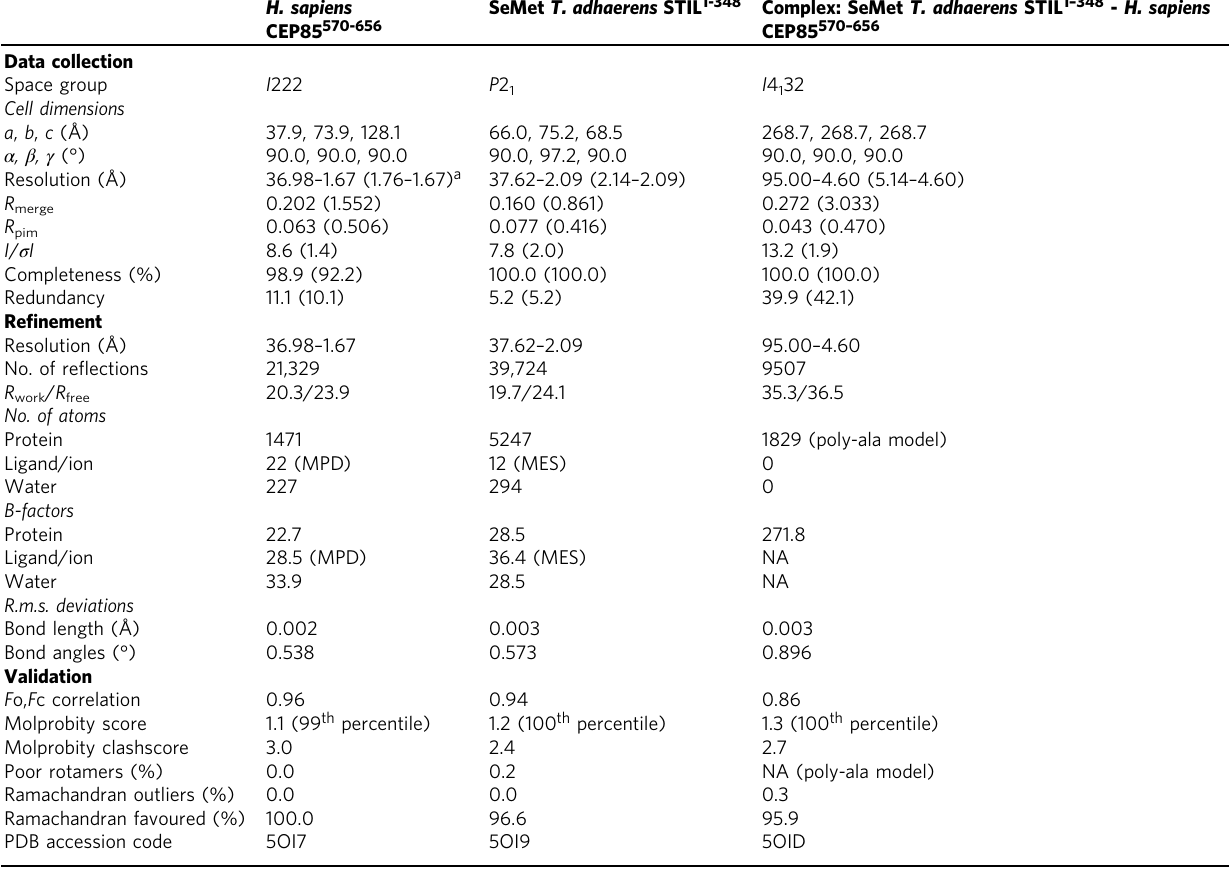
Table 1 Data collection and re fi nement